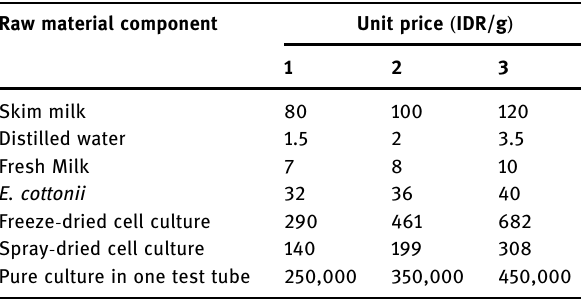
Table 3: Raw material cost of hydrated L. acidophilus